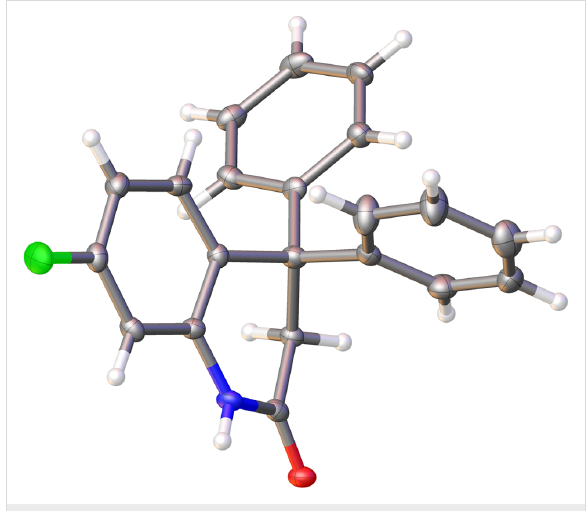
Figure 1: Molecular structure of 2f (ellipsoid contours of probability levels are